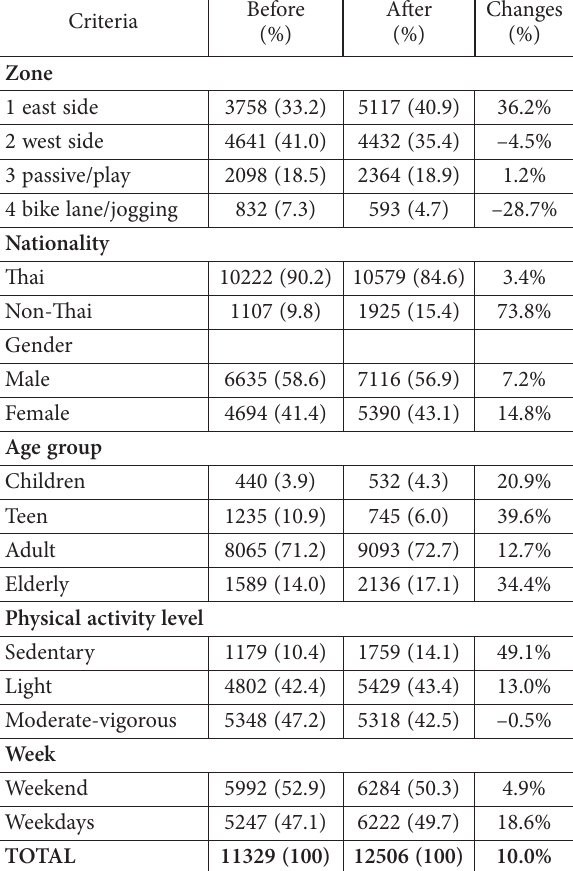
Table 1. The number of visitors before and after park